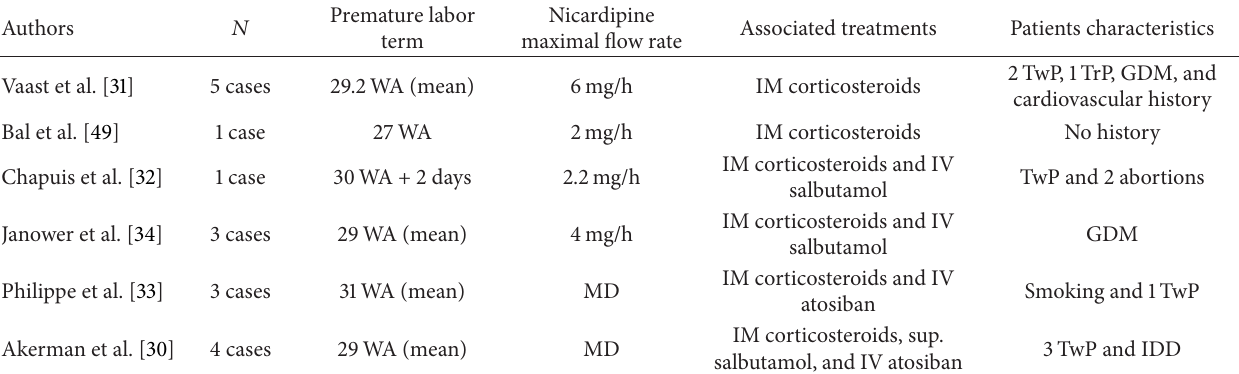
Table 3: Published case reports on APE occurring during a tocolytic treatment with nicardipine.